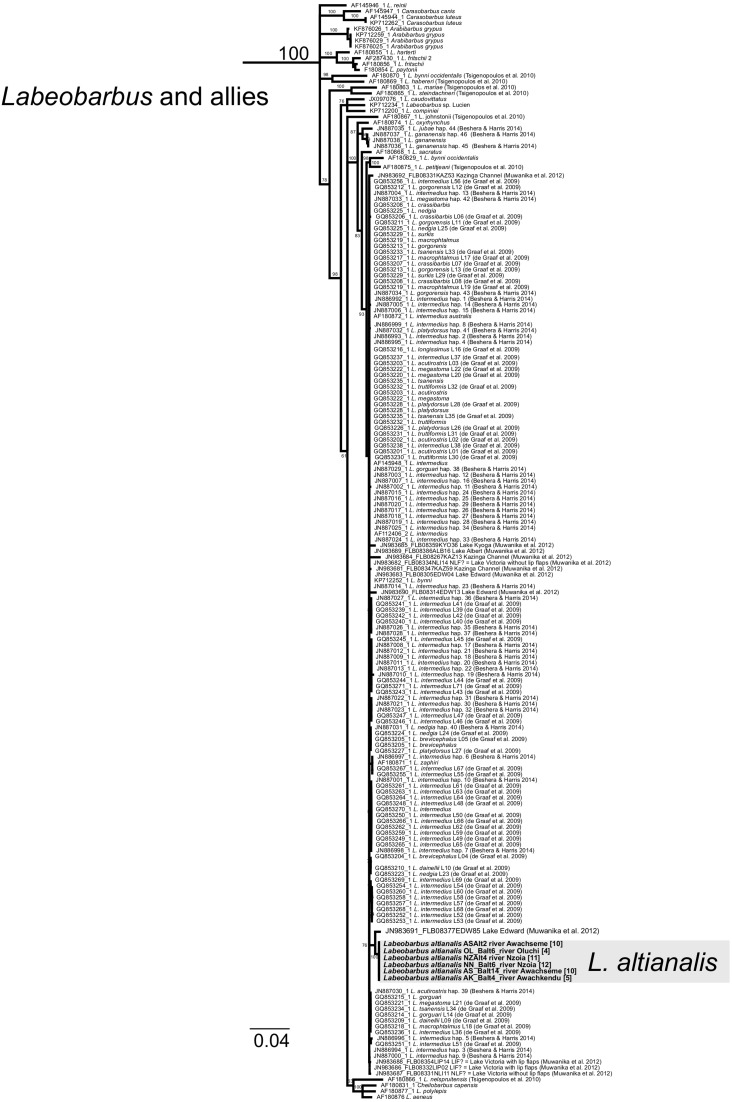
Inferred relationships within the clade Labeobarbus and allies (expanded from Fig. 3) based on the Cytb gene.RAxML bootstrap consensus (60% majority rule) tree. Boldfaced taxon labels correspond to our specimens of L. altianalis. Numbers in brackets correspond to localities in Fig. 1. Genera names follow (Skelton, Swartz & Vreven, 2018; Vreven et al., 2016).